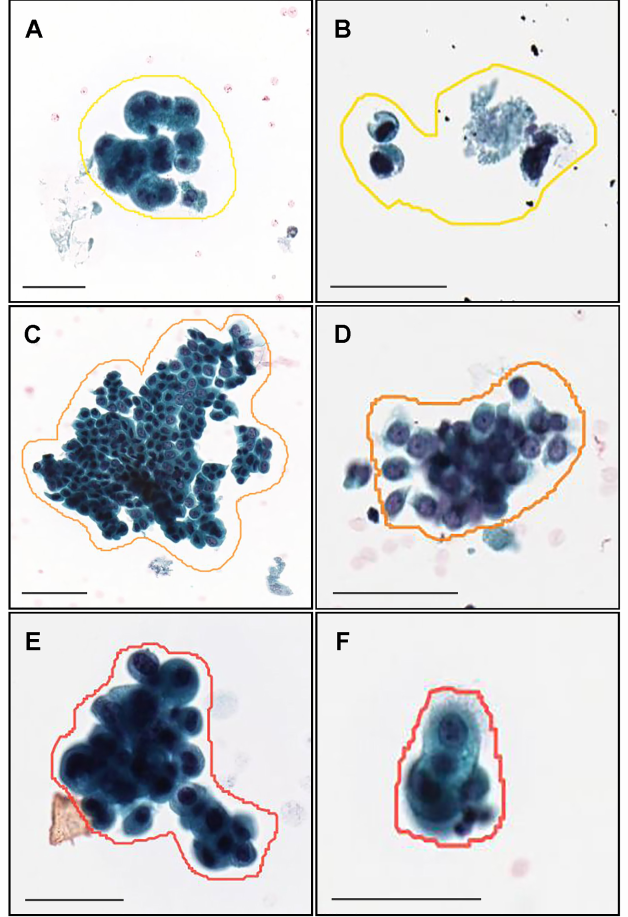
Figure 1. Representative manually drawing annotation image for neoplastic labels on urine liquid- based cytology (LBC) whole slide images (WSIs). The atypical urothelial cells ( A , B ) were annotated as atypical cell label. The suspected low grade urothelial carcinoma (LGUC) cells ( C , D ) were annotated as LGUC cell label and high grade utorhelial carcinoma (HGUC) cells ( E , F ) were annotated as HGUC cell label. The three labels (atypical cell, LGUC cell, and HGUC cell) were grouped as neoplastic label for fully supervised learning. Scale bars are 50 µ